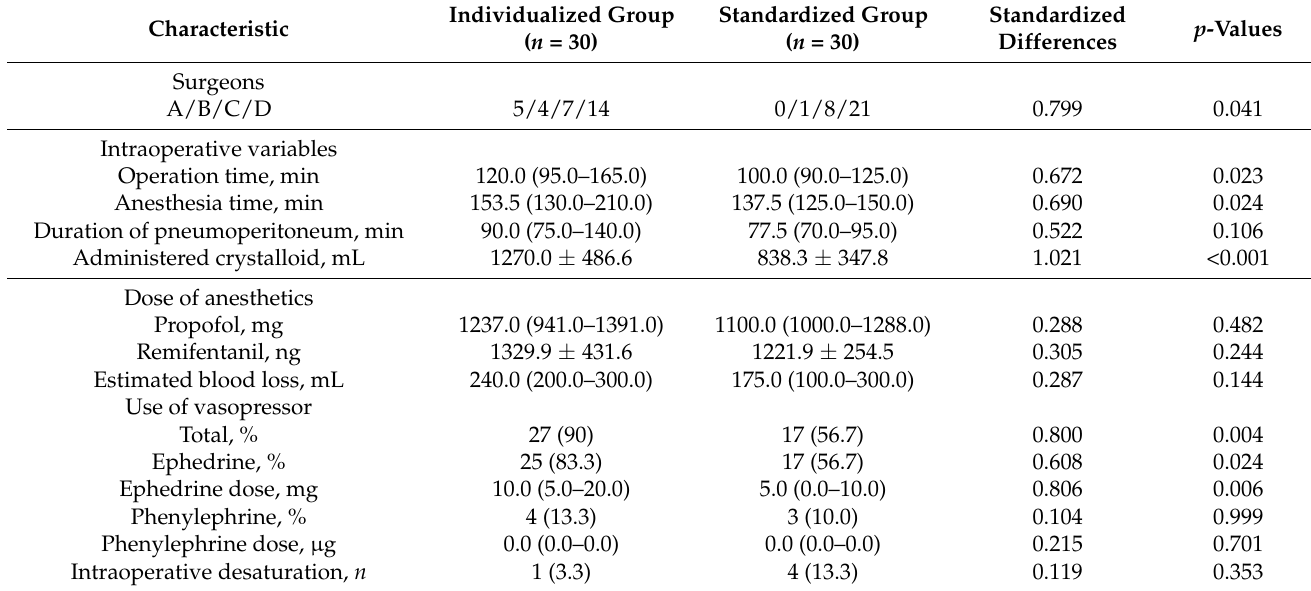
Table 2. Comparison of intraoperative anesthesia-related variables between the individualized and standardized